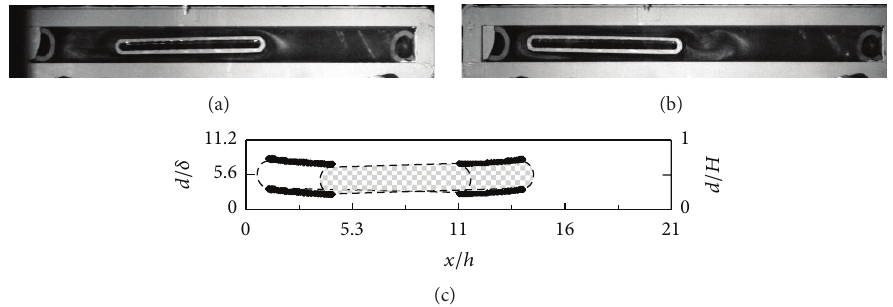
Figure 14: The body in the extreme position of the container during vibration ((a): left, (b): right) and the oscillating body motion trajectory (c) during the oscillation, 𝑓 = 9.9 Hz.